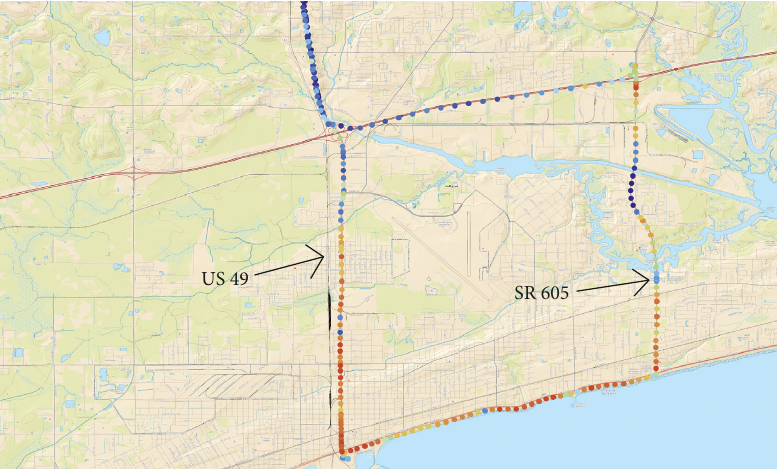
Figure 18: Virtual potential temperature in Gulfport area on 10 August 2015 (collected counterclockwise). Colorized by quantiles for south and northbound separately to emphasize